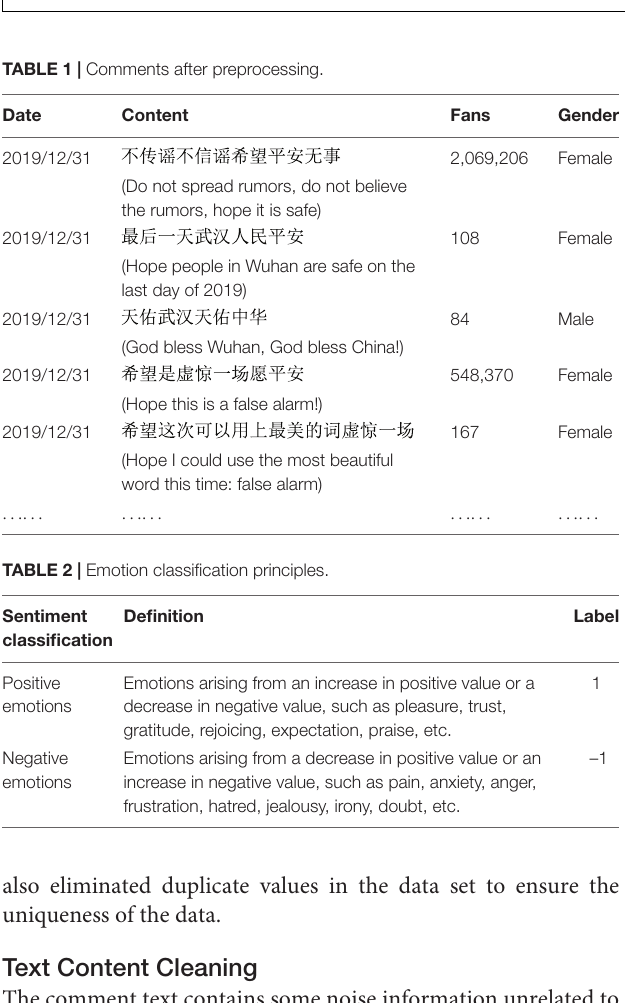
FIGURE 1 | Weibo user comments.